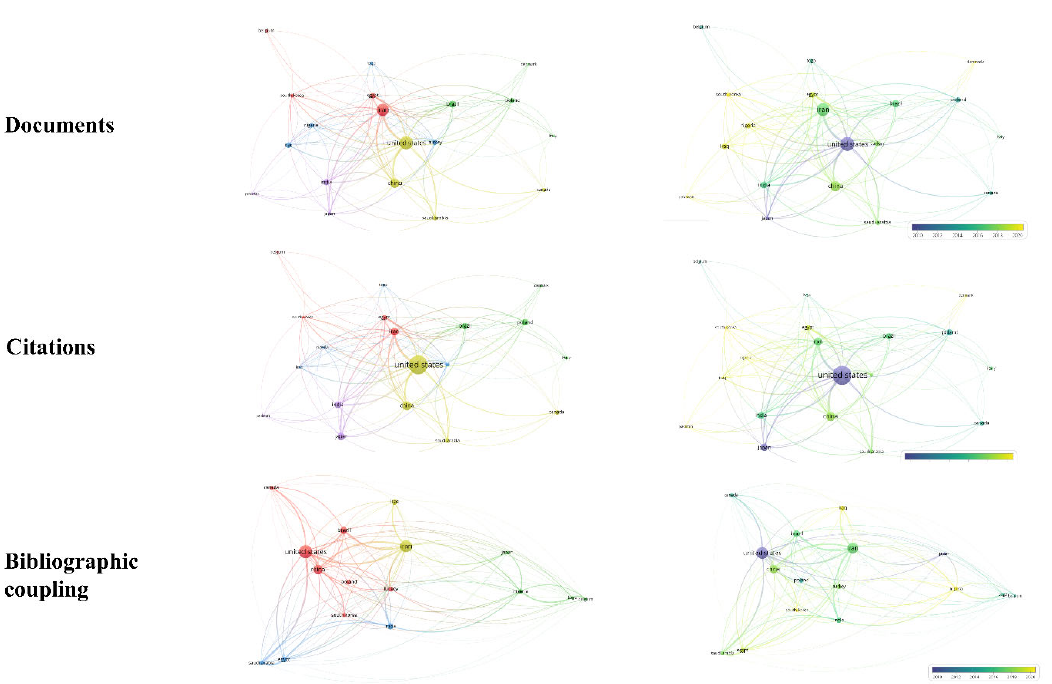
Figure 12. Heat map for numbers of papers by country.